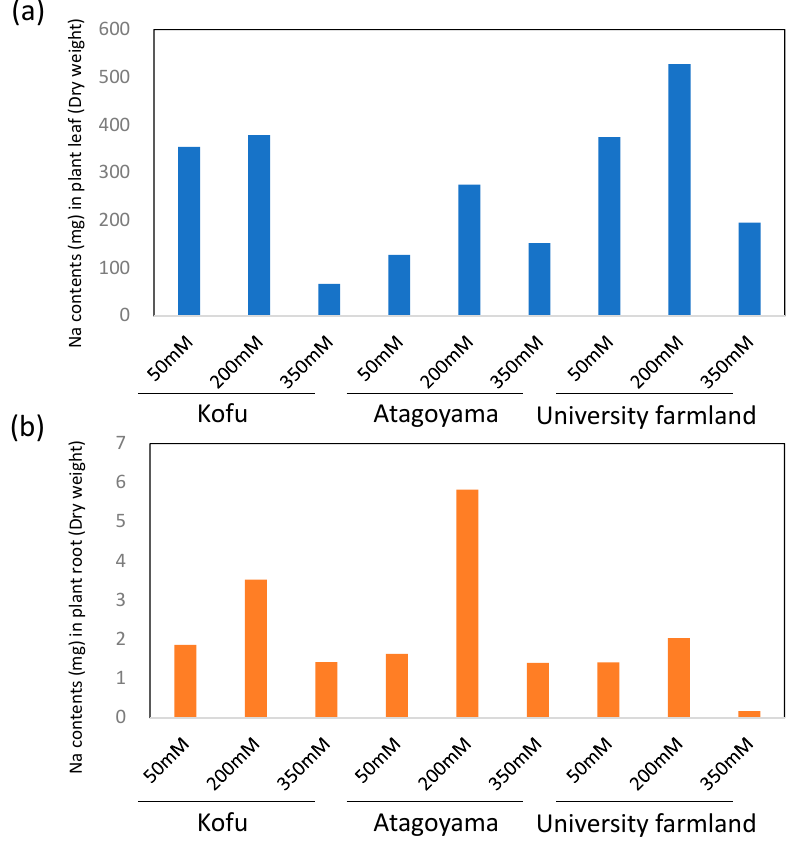
Figure 1. Amount of sodium taken up by ice plants under different salinity conditions. ( a ) Leaves, ( b ) roots.